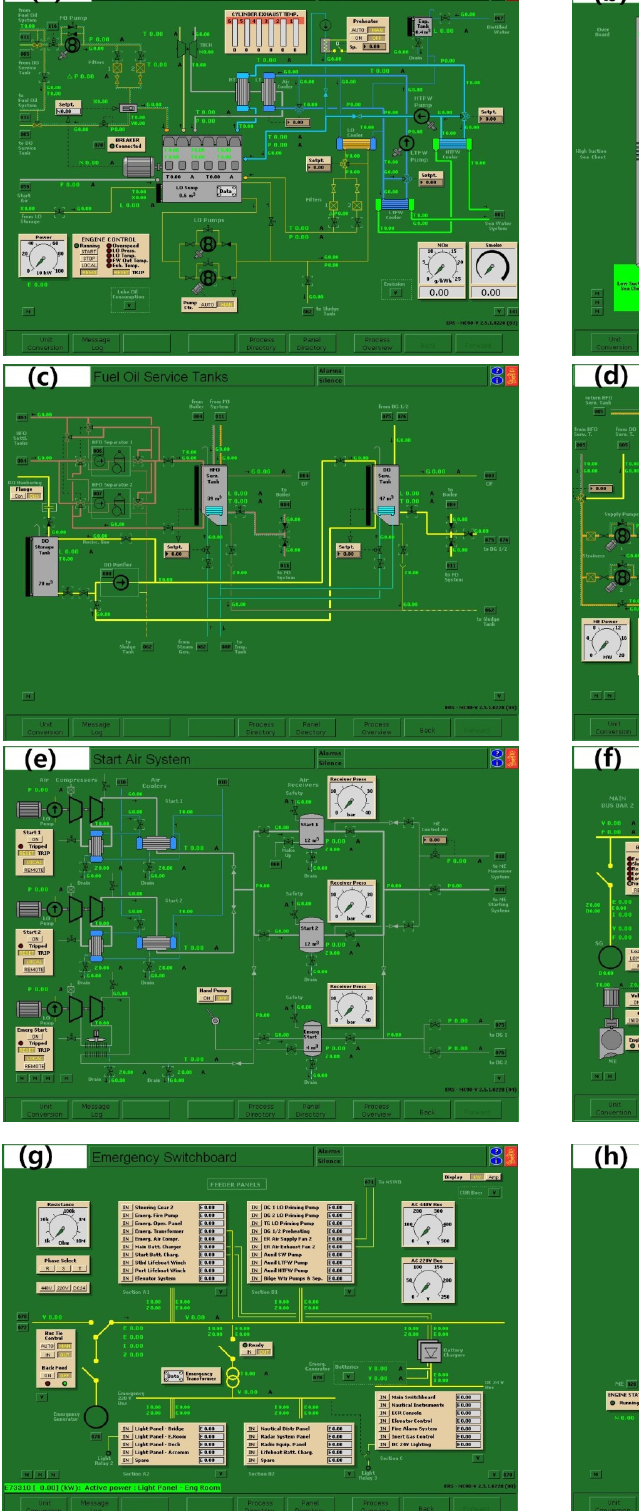
Figure 1. Neptune simulator MC90 software: ( a ) MD75 interface, ( b ) MD01 interface, ( c ) MD05 interface, ( d ) MD11 interface, ( e ) MD59 interface, ( f ) MD70 interface, ( g ) MD73 interface, ( h ) MD77 interface.